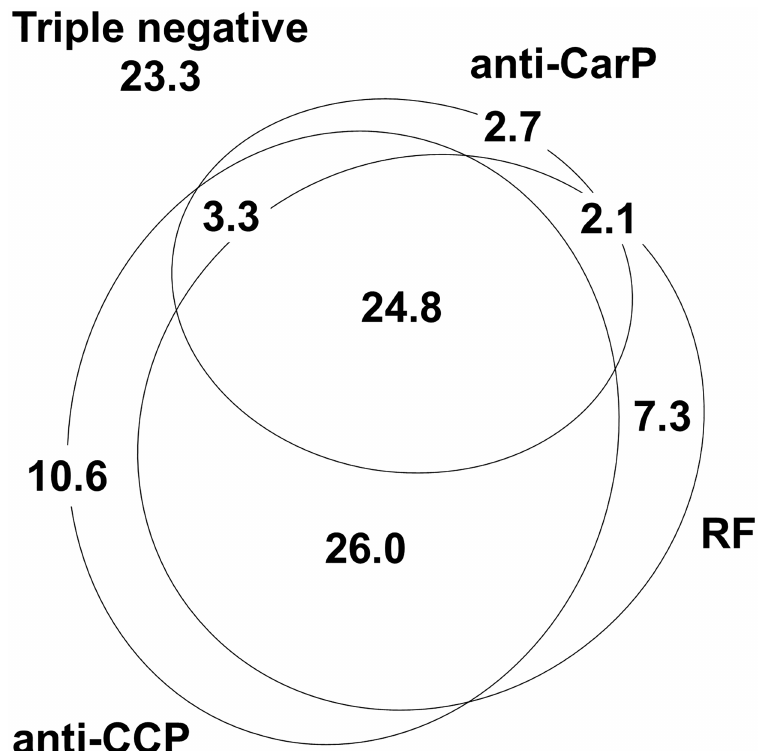
Fig 1. Distribution of patients with RA positive for the different autoantibodies. A proportional Venn diagramrepresentingpercentages (%) of patients in each of the antibody strata: anti-CCP positive in the lower left oval, RF positive in the lower right oval and anti-CarP positive in the upper one. Percentage of triple negativesis shownoutside the Venn diagramin the upper left corner.